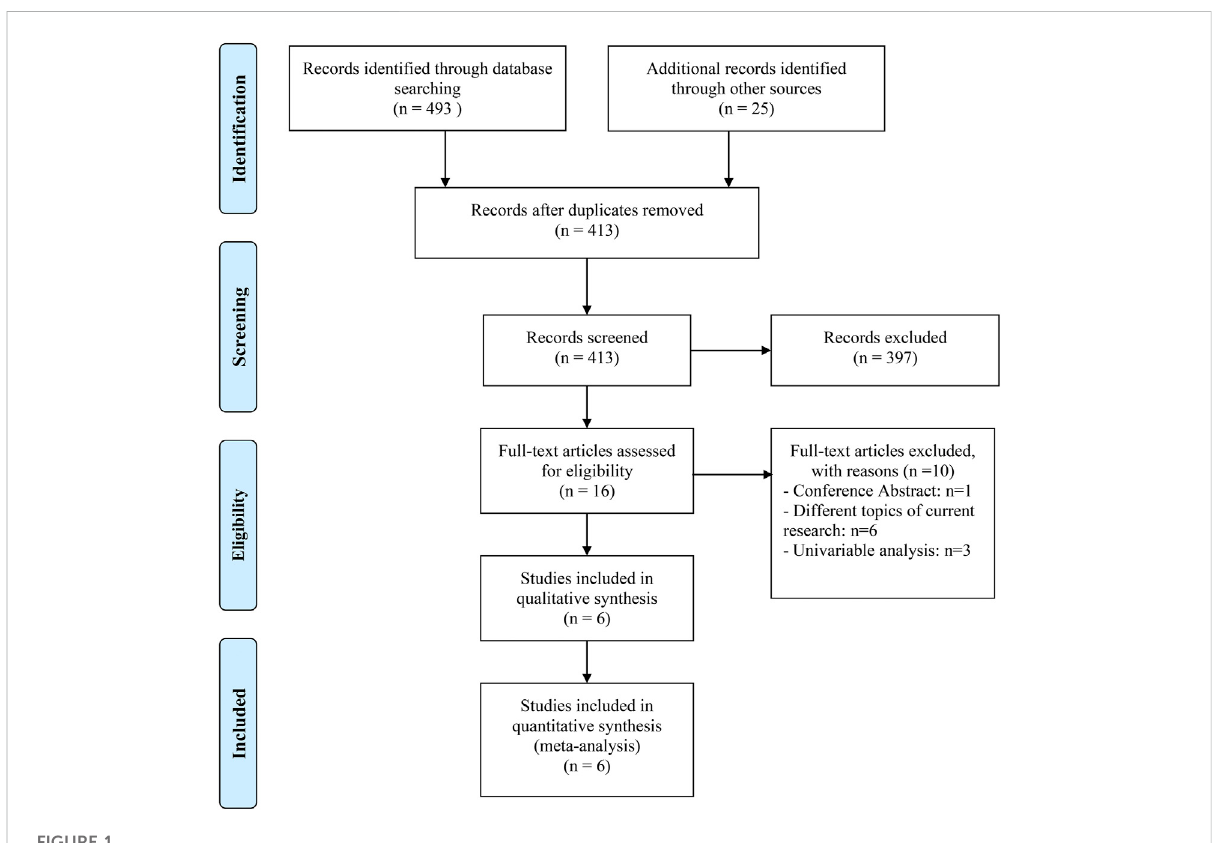
The fl ow diagram of identifying eligible